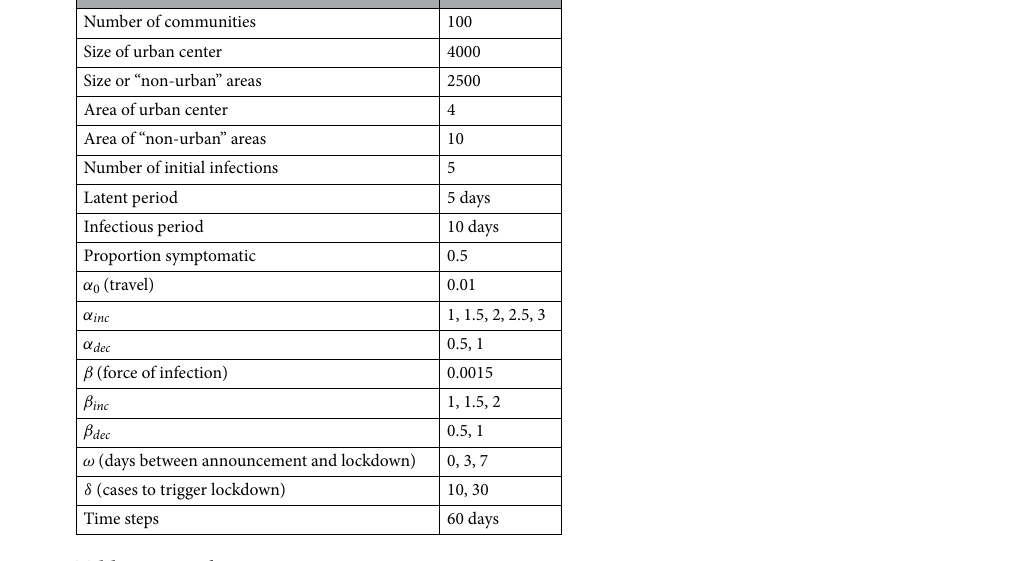
Table 1. Simulation